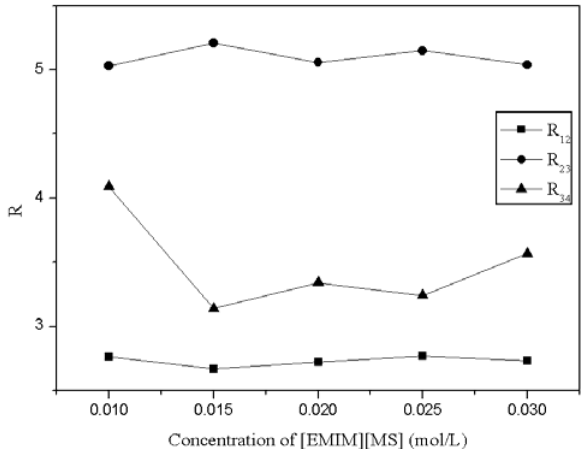
Figure 9 . Effect of concentration of [EMIM][MS] on the resolution of the four compounds. (Error bars smaller than the symbols are not shown). 1: chlorogenic acid, 2: caffeic acid, 3: scoparone, 4: rutin; R = resolution of chlorogenic acid and caffeic acid, R 12 of caffeic acid and scoparone, R = resolution of scoparone and 34